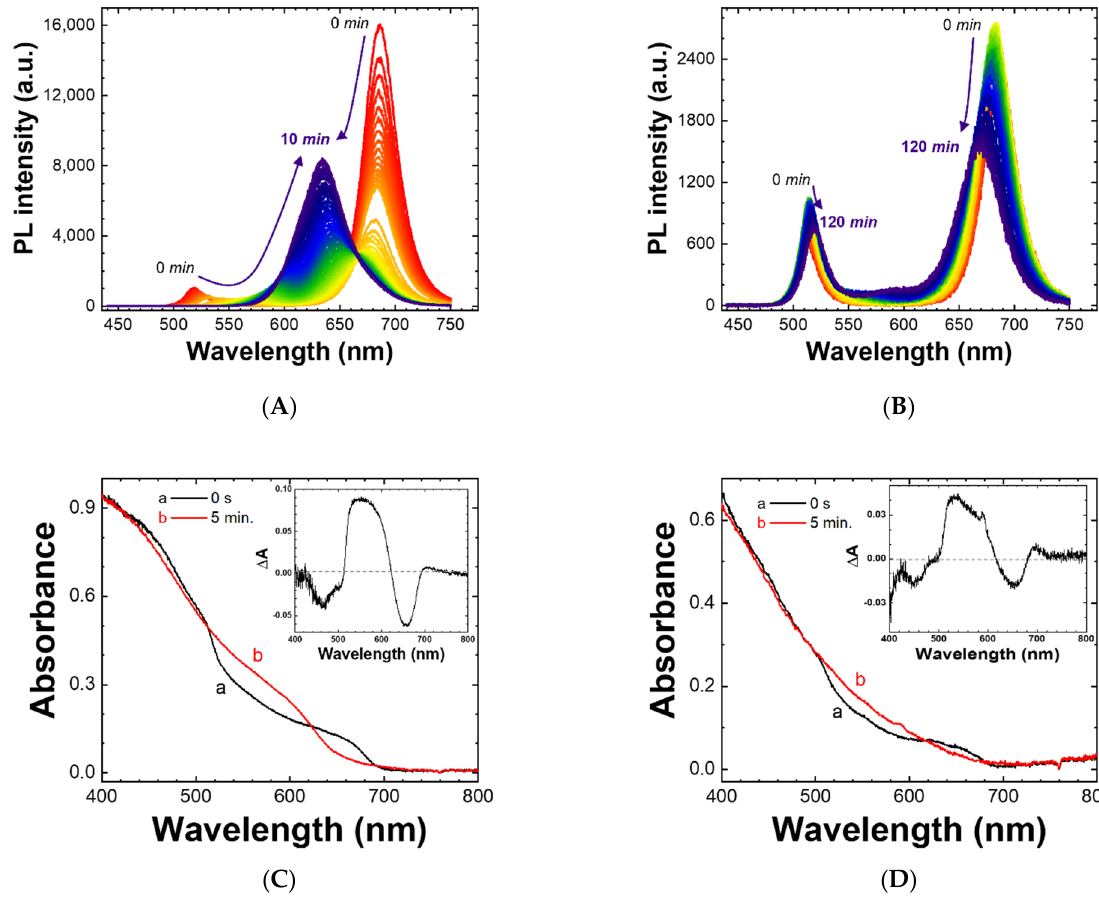
Figure 4. ( A,B ) In situ photoluminescence spectra of the halide exchange process among CsPbI 3 and CsPbBr 3 PQDs at 318 K ( A ) without PbSO 4 -oleate coverage on PQDs and ( B ) with PbSO 4 -oleate coverage on PQDs. ( C , D ) In situ absorption spectra for the halide exchange process among CsPbI 3 and CsPbBr 3 PQDs ( C ) without PbSO 4 -oleate coverage on PQDs and ( D ) with PbSO 4 -oleate coverage on PQDs. Initial absorbance (a, 0 s) and absorbance during halide exchange (b, 5 min.) (inset: ∆A between a and b). Note that absorbance measurements were performed intermittently for shorter periods owing to the data collection and storage processing time required by the lab-built IPCE-CCD setup.